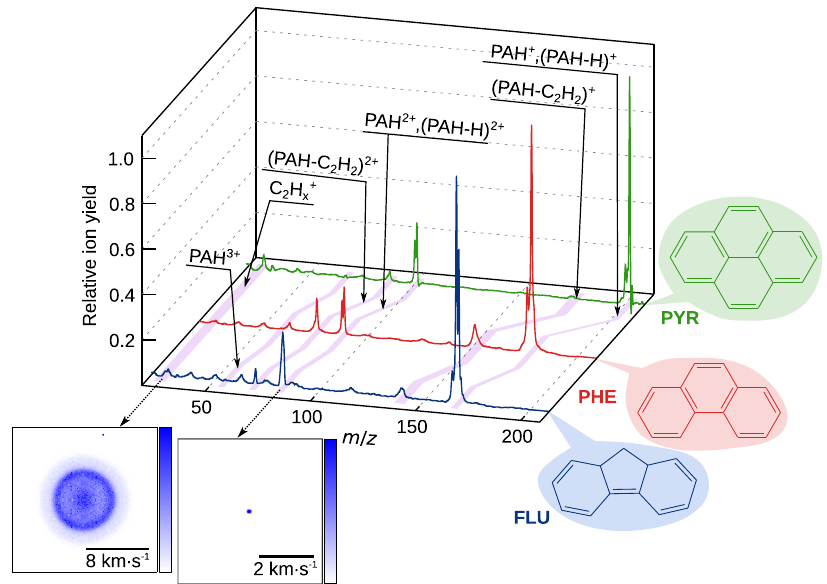
Fig. 1 XUV pulse only data. Ion mass spectra for the three PAH molecules, pyrene (PYR), phenanthrene (PHE), and fl uorene (FLU), after irradiation with the XUV pulse at 30.3 nm, in green, red, and blue respectively. Intensities are normalized on the height of the respective parent ion PAH + . Insets show the velocity-map images for the PAH 2 + dication and C 2 H þ x for FLU (four-fold symmetrization about the laser polarization and vertical axis applied). (a) velocity-map images